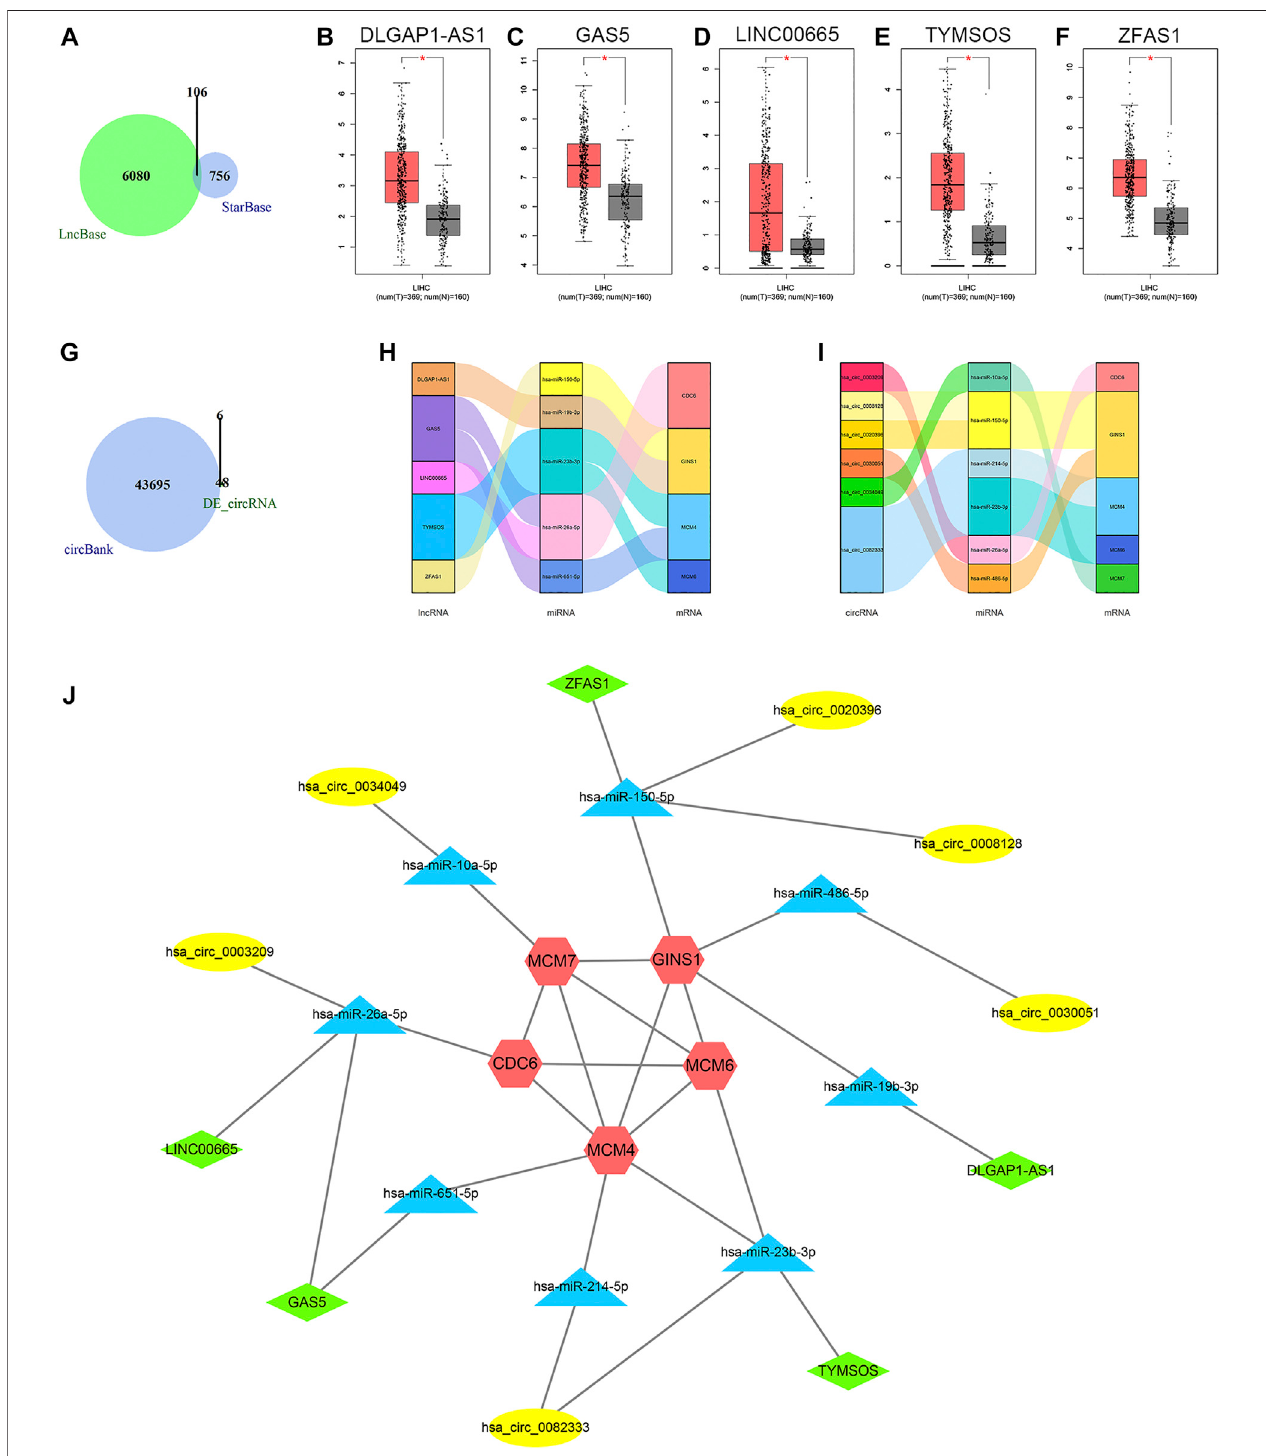
FIGURE 7 | Results of ceRNA prediction and ceRNA network construction. (A) Venn diagram of the common predicted lncRNAs. (B − F) Differential expression analysis of the lncRNAs in GEPIA. Tumor tissue is shown in red, and normal tissue is shown in gray. (G) Venn diagram of the predicted circRNAs and differentially expressed circRNAs. Sankey diagrams of the lncRNA-miRNA-mRNA regulatory relationship (H) and circRNA-miRNA-mRNA regulatory relationship (I) . (J) The ceRNA network. Red represents the mRNAs, blue represents the miRNAs, green represents the lncRNAs, and yellow represents the circRNAs. CeRNA, competing endogenousRNA;lncRNA,longnon-codingRNA;GEPIA,GeneExpressionPro fi lingInteractiveAnalysis;circRNA,circularRNA;miRNA,microRNA;mRNA,messenger RNA; LIHC, liver hepatocellular carcinoma; T, tumor; N, normal; DE_circRNA, differentially expressed circular RNA.